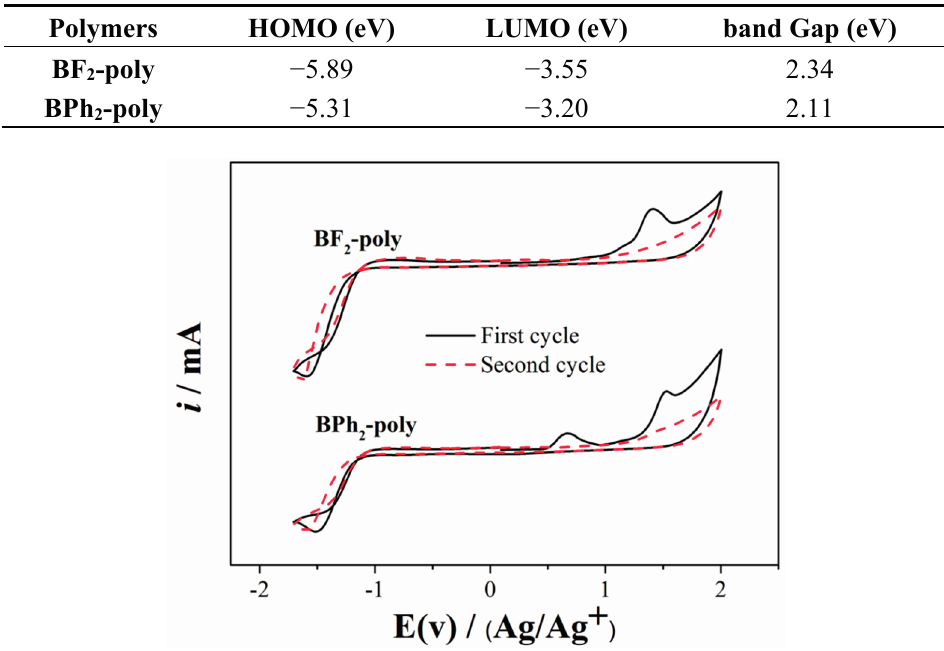
-poly ( a ) and BPh 2